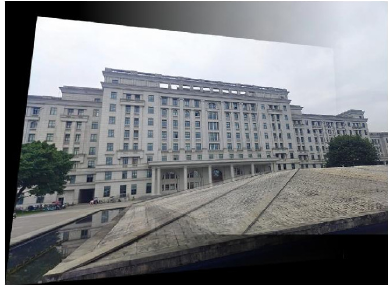
Figure 10. The stitched image generated by using M ab .